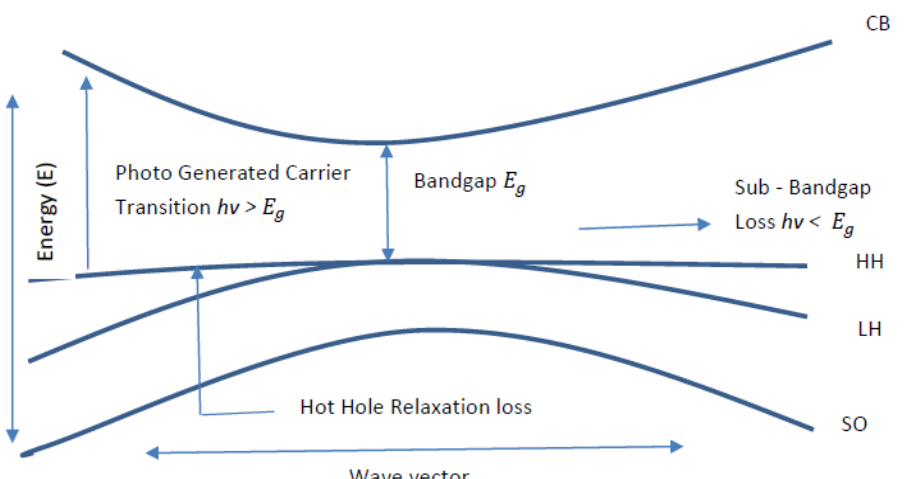
Figure 5. Photogenerated carrier transition, hot carrier relaxation, and sub-bandgap loss depicted in band gap GaAs (Gallium Arsenide). CB: The lowest conduction band., LH is the light hole valence, SO is the split-off hole valence band. [Authors own study] [116,117].